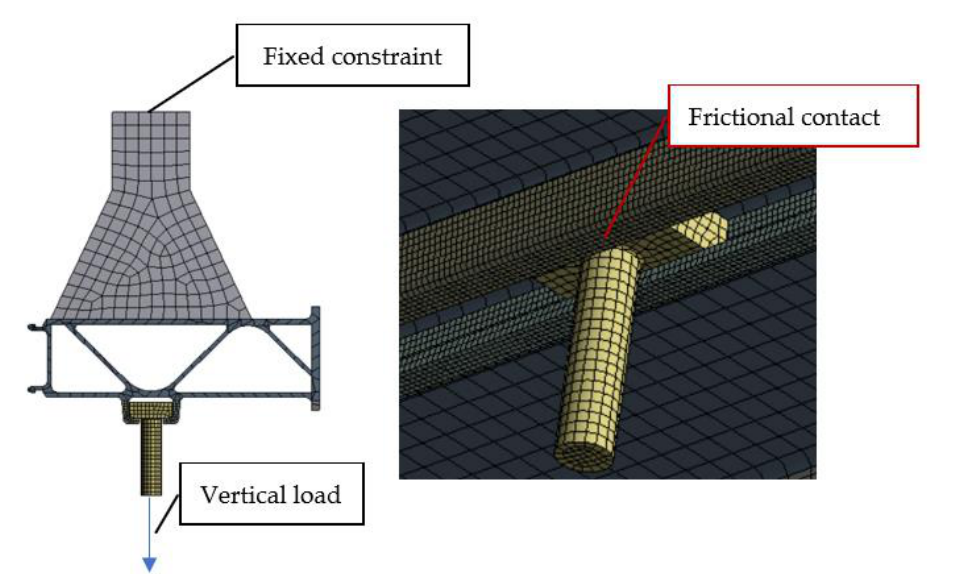
Figure 5. Finite element model of the test structure.